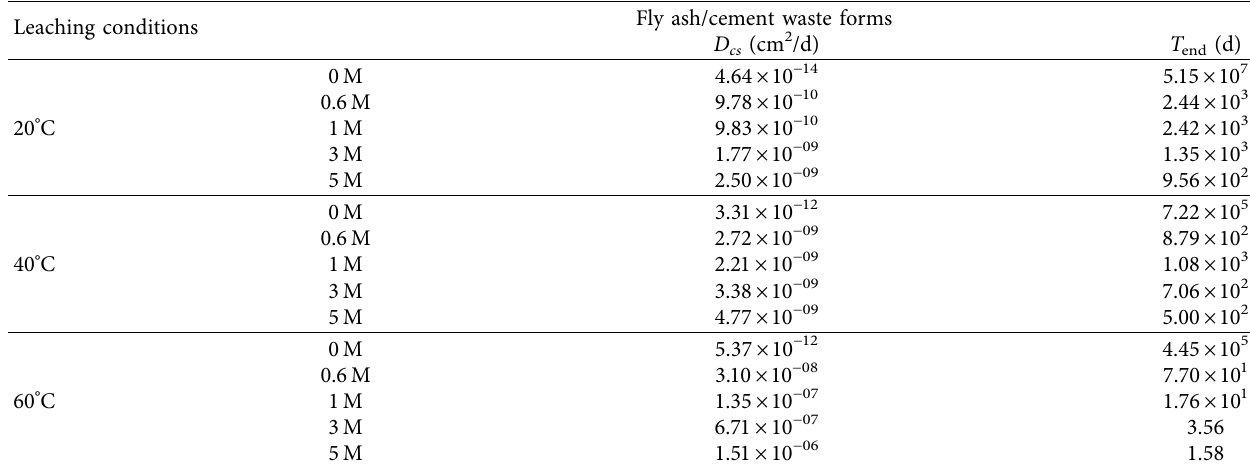
Figure 11: The relationship of ADC between Ca 2+ and Sr 2+ in fly ash/cement waste forms. Table 6: ADC of Cs + ( D cs ) and time for complete leaching ( T end